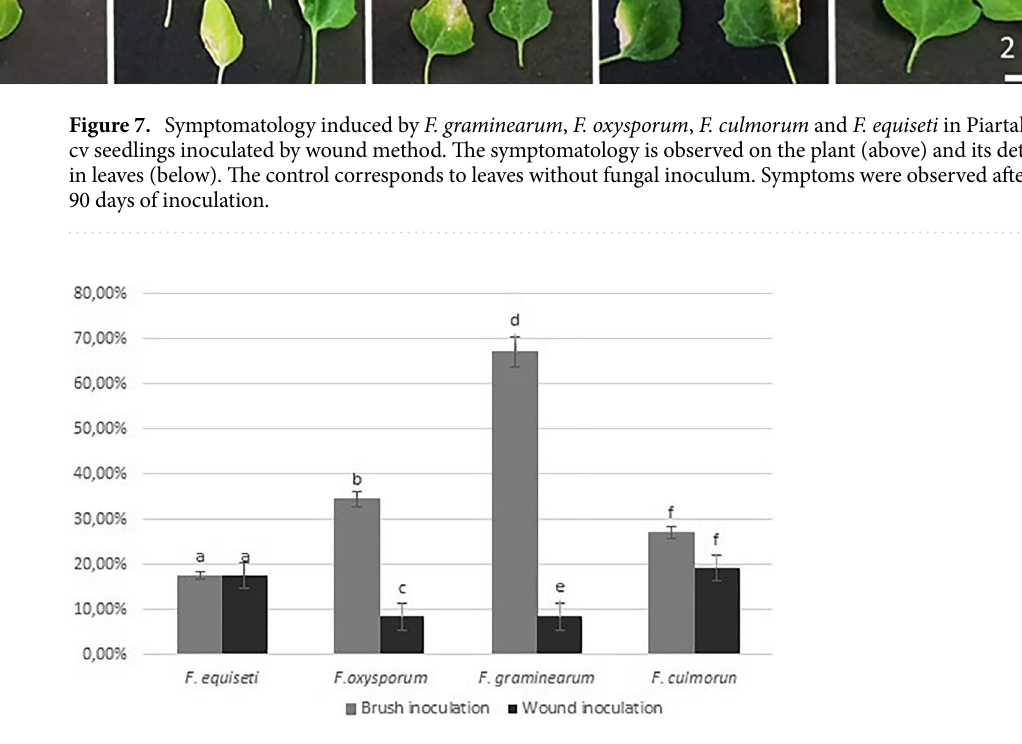
Figure 8. Disease Incidence of F. equiseti, F. oxysporum , F. graminearum , F. culmorum in quinoa seedlings. The data are expressed as the mean with confidence interval using Student’s T-test ( p < 0.05). Letters